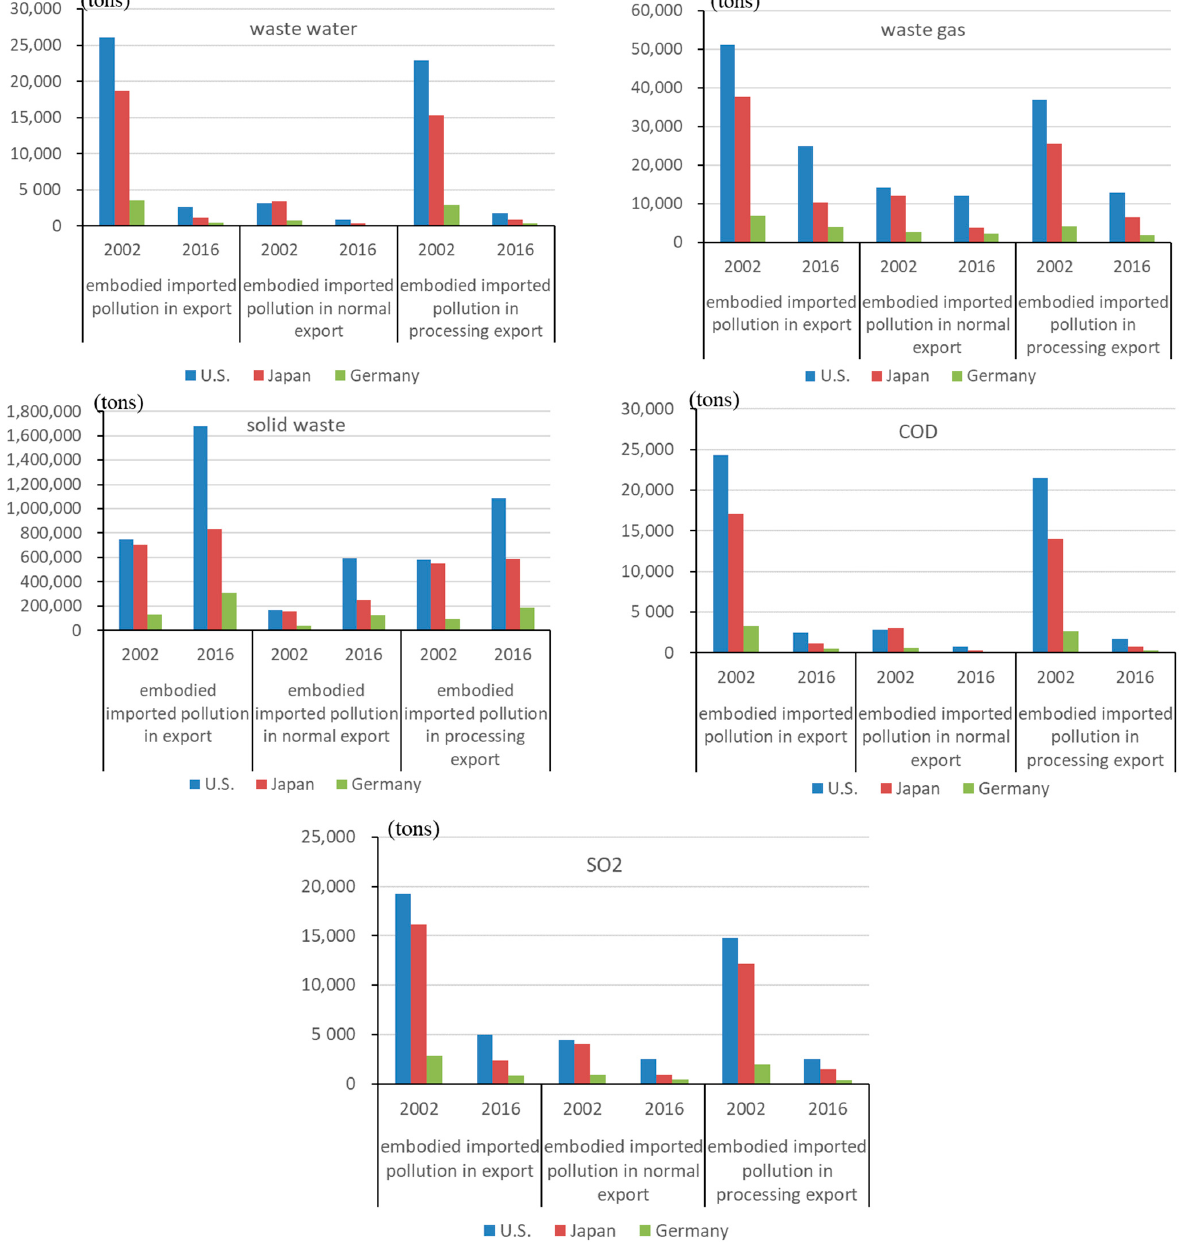
Figure 3. The embodied imported emission in China’s exports to the US, Japan, and Germany (unit: